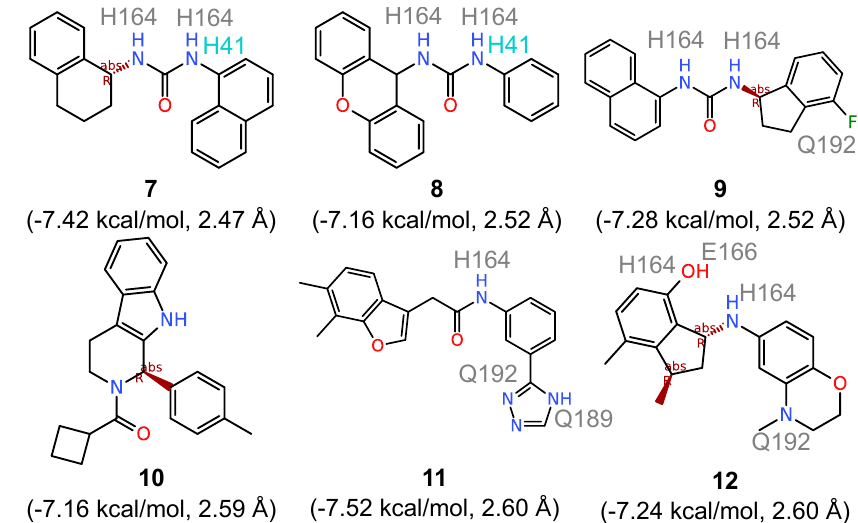
Figure 3. Synthetic compounds with the highest computed affinities for the substrate site of the SARS-CoV-2 3CL pro enzyme obtained from ensemble docking. The average ∆ G and d dyad values are given in parentheses while ligand atoms involved in hydrogen bonding with 3CL pro binding site residues (indicated) are also shown.